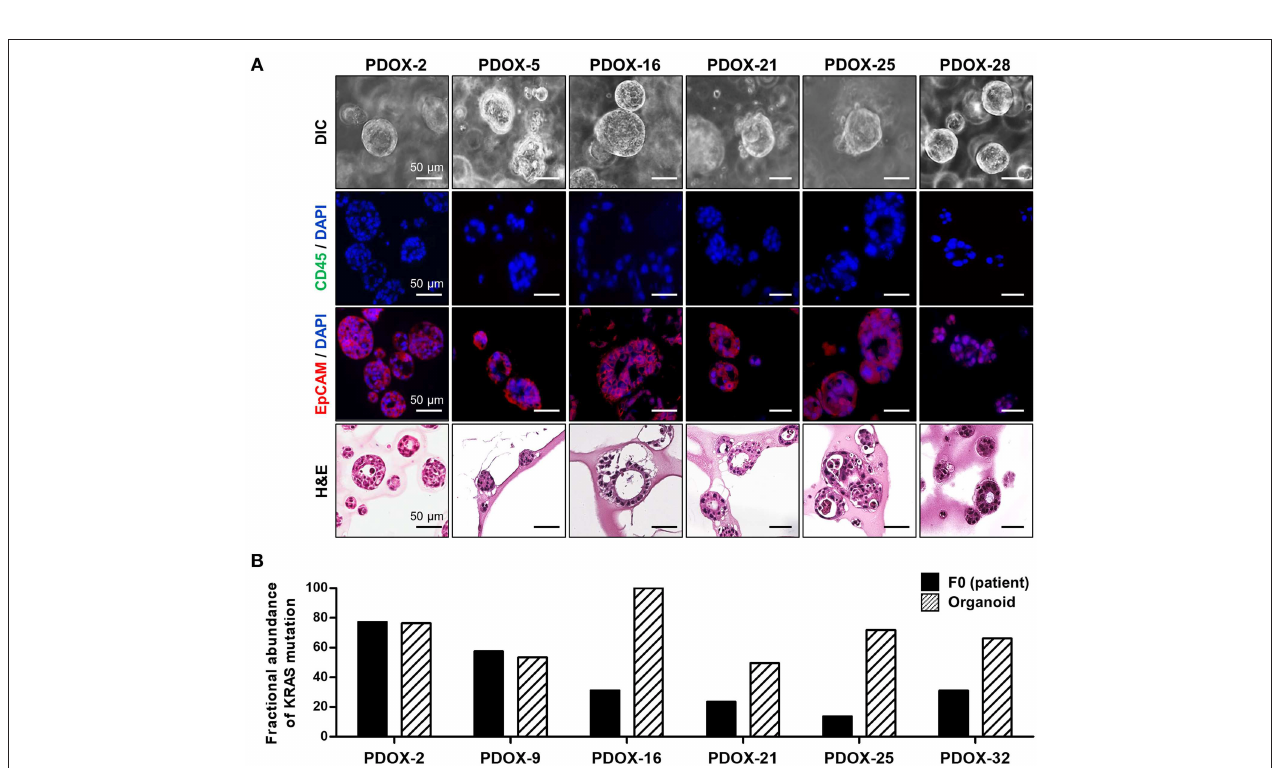
FIGURE 3 | Characterization of PDOX-derived organoids. (A) Representative organoid images using DIC, EpCAM staining using immunofluorescence and H&E. (B) Expression of mutated KRAS in PDOX and derived organoids. Fractional abundance of KRAS mutations by ddPCR in primary tumors and PDOX-derived organoids. Multiplex KRAS mutation detection kit that encompasses 7 common mutations (G12A, G12C, G12D, G12R, G12S, G12V, and G13D) was used in this experiment.